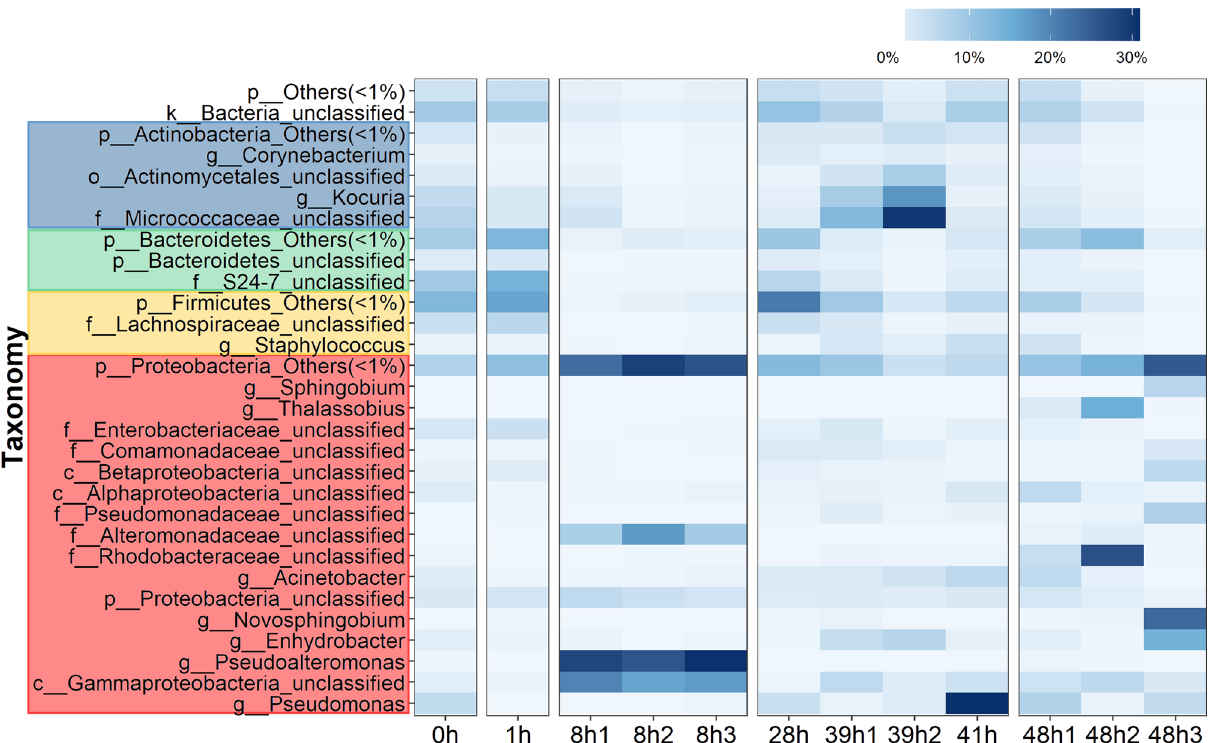
Figure 2. Relative abundance of bacterial OTU compositions at genus level. For OTU classification where genus could not be identified, the deepest classification was given (abbreviated g_ for genus, f for family, c for class and o for order, respectively). Genus names were color highlighted based on phylum, and in each phylum bacterial genera of < 1% abundance were represented in “p_name_Others (< 1%)”.